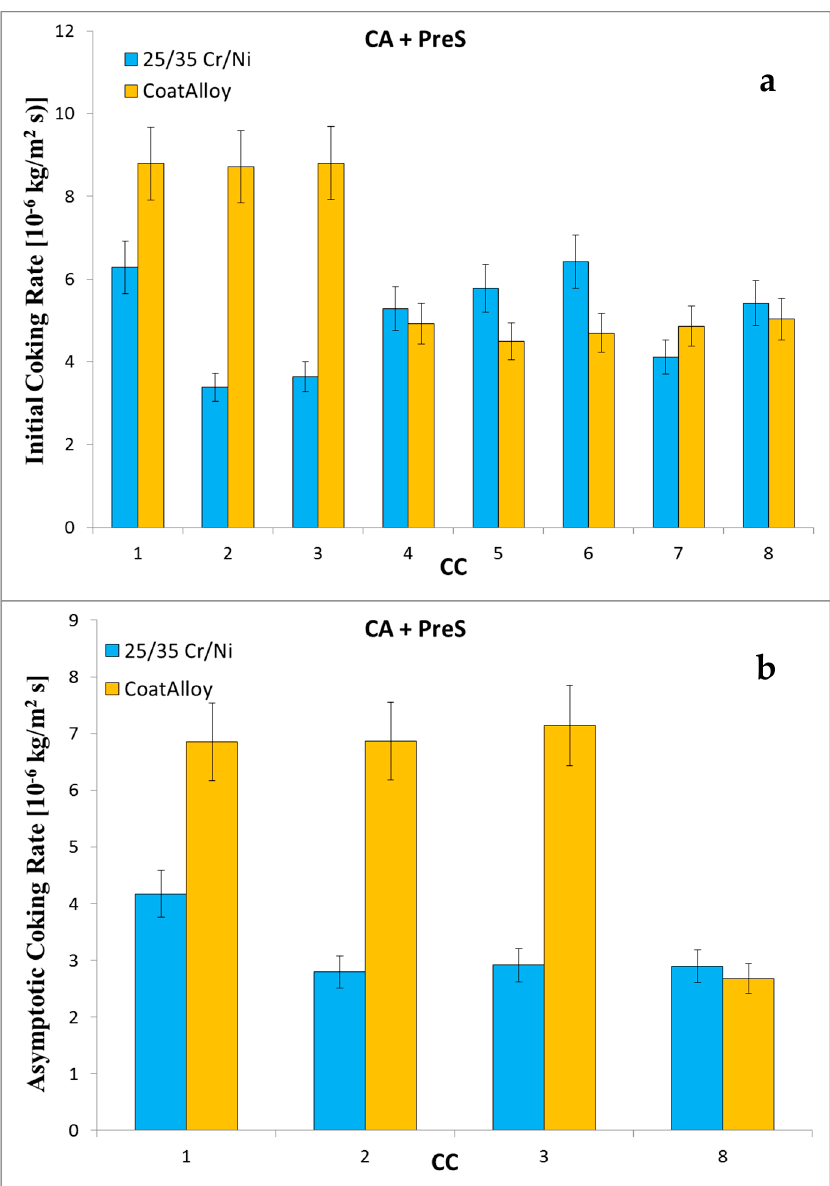
Figure 6. Initial ( a ) and asymptotic ( b ) coking rates of PreS + CA experiments.